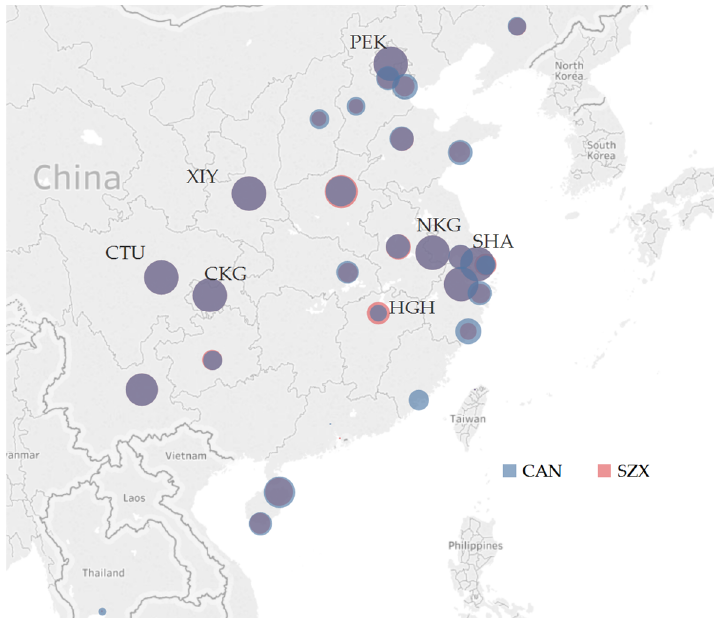
Figure 8. Top 30 airports based on number of flights connecting with CAN/SZX.